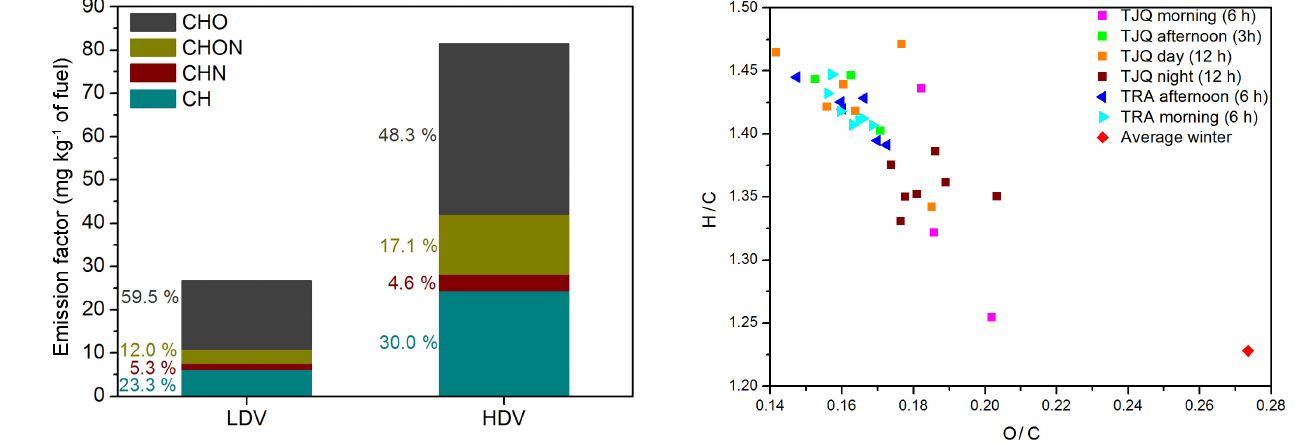
Figure 4. Total average EFs calculated for LDVs and HDVs divided into groups containing CHO, CHON, CHN, and CH.